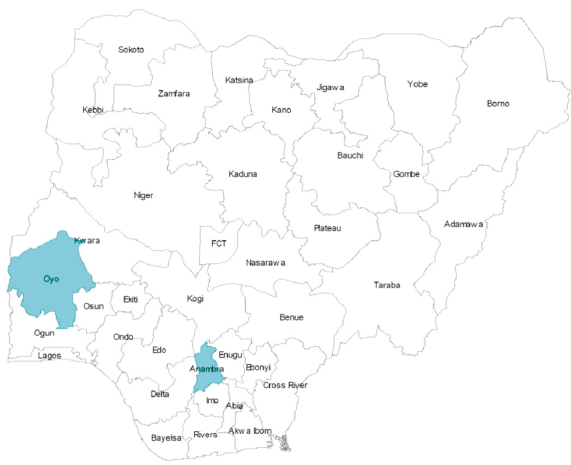
Figure 1: Map of Nigeria showing the study communities.